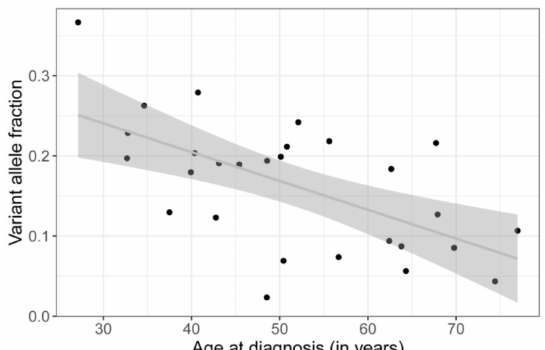
Figure 4. Linear regression analysis shows a significant negative correlation of patients age and VAF ( p =